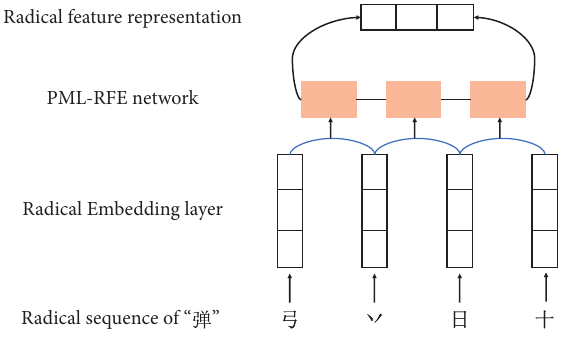
Figure 4: Architecture of radical feature extraction module.